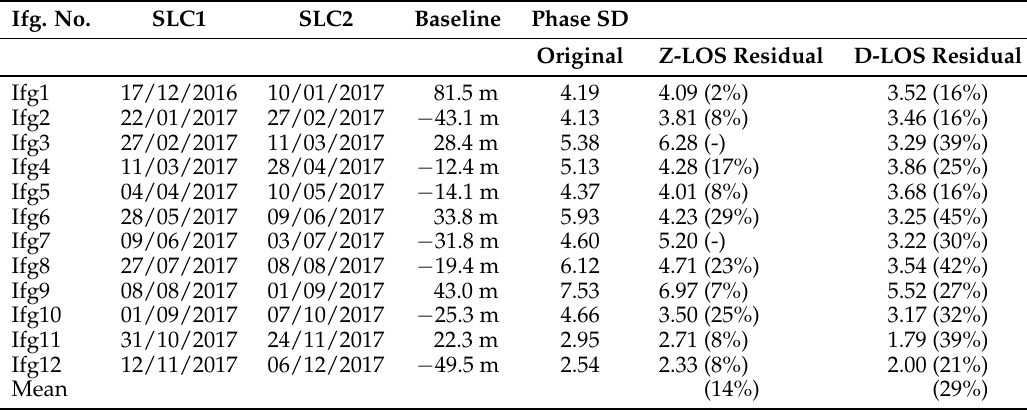
Table 3. Statistical comparison of different mitigation methods for 12 Sentinel-1 interferograms used in Almería, Spain. Values in parentheses are the correction percentage of (original-residual)/original. Ifg. No. SLC1